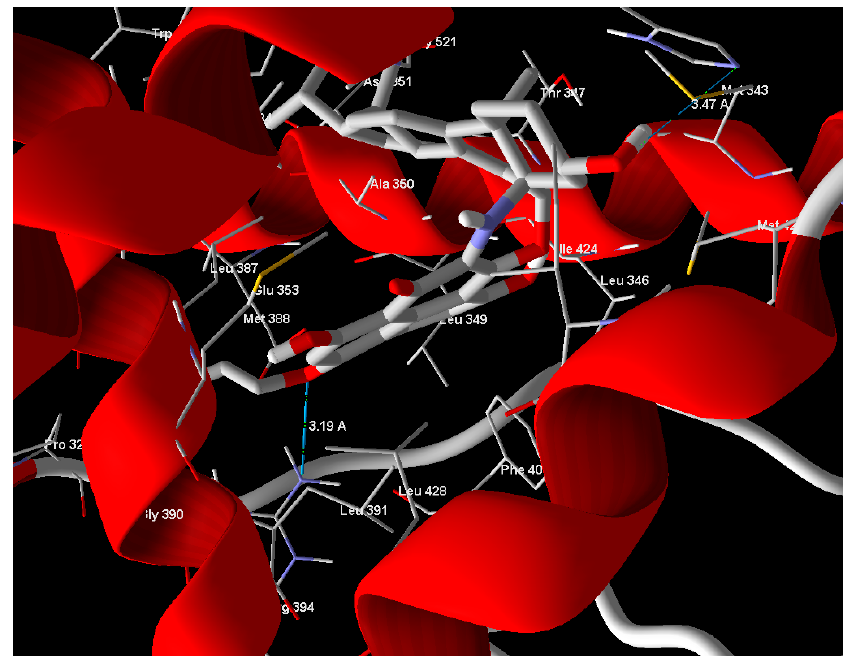
Figure 4. Compound 1 showed hydrogen bonds interaction with ER α -LBD active site.